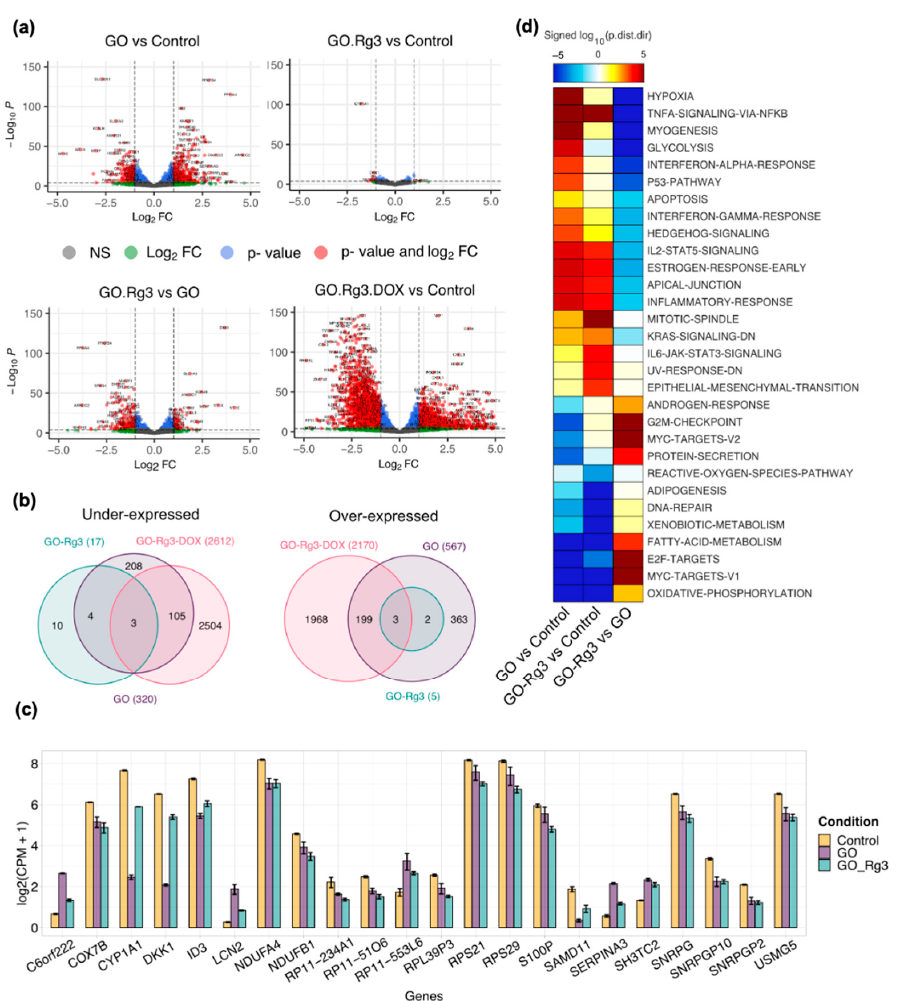
Figure 3. RNA sequencing supports mitigated toxicity of GO by Rg3 conjugation. ( a ) Volcano plots show differentially expressed genes of each treatment. The cut-off for |log2FC| is >1; the cut-off for adjusted p -value is 1 × 10 − 4 , NS, not significant. ( b ) Venn diagrams showing the number of common and specific overexpressed (right) and under-expressed genes (left) in treatments compared with the control. The cut-off for |log2FC| is >1; the cut-off for adjusted p -value is 0.01. ( c ) Barplot of expression of 22 genes differentially expressed genes in GO–Rg3 compared with control. Shown are the log2 transformed count per million (CPM) levels of genes in untreated samples (yellow), treated samples with GO (purple), and treated samples with GO–Rg3 (green). The cut-off for |log2FC| is >1; the cut-off for adjusted p -value is 0.01. ( d ) Directional GSA of DE analysis for GO- and GO–Rg3-treated versus control and GO–Rg3- versus GO-treated samples. Only the Hallmark gene set collection is shown here and sets with <10 genes were excluded. The more significant (lower value) of the two directional p -values for each gene set is shown in the heatmap as a log10-transformed value. The distinct directional gene set p -values (p adj.dist.dir ) are calculated for coordinated increases (p adj,dist-dir-up ) and decreases (p adj,dist-dir-down ) in expression. The value is also “signed,” meaning that gene sets with a more significant decrease than increase (p adj,dist-dir-down < p adj,dist-dir-up ) are negative; otherwise, they are positive. Only gene sets with a p adj,dist-dir less than 0.01 in at least one comparison are